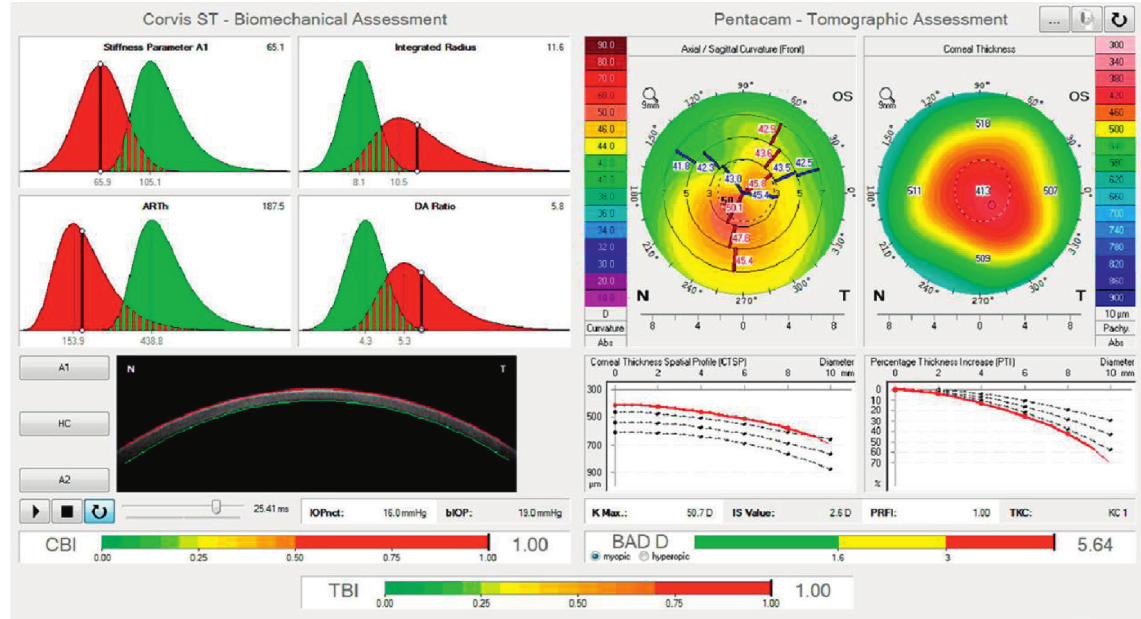
Figure 2: Corvis ST biomechanical/tomographic assessment of a keratoconic eye. Biomechanical assessment shows increase in DA ratio and integrated radius, and decrease in ARTh and SP-A1 (top left). Tomographic assessment shows central corneal thinning with an asymmetric bow tie pattern (top right). The percentage of thickness increase (PTI) graph shows an inferior escape from the normal mean. CBI, TBI, and BAD are all increased (bottom).